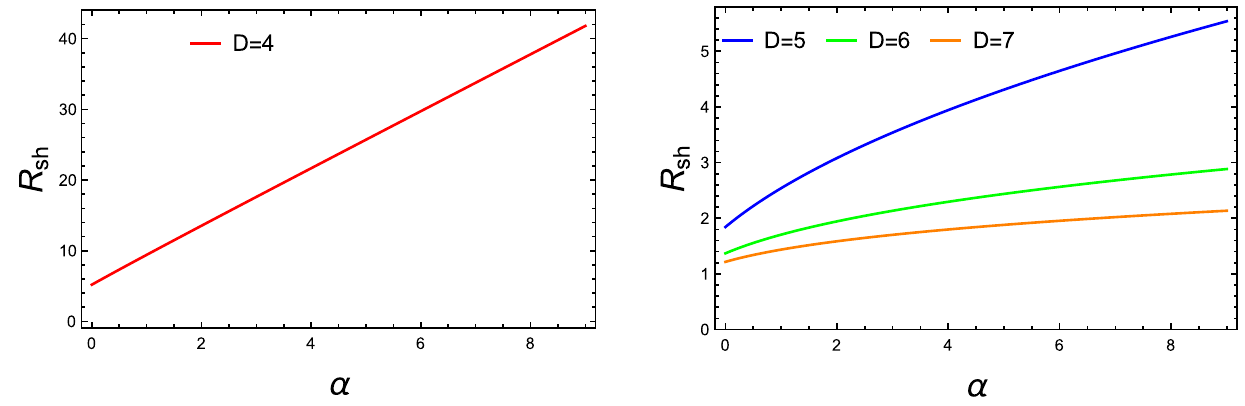
Fig. 5 The shadow radius R sh with respect to parameter α , where the spacetime dimension is taken to be D = 5 , 6 , 7, respectively, and the case of D = 4 (left diagram) is attached for comparison. Here we set M = 1